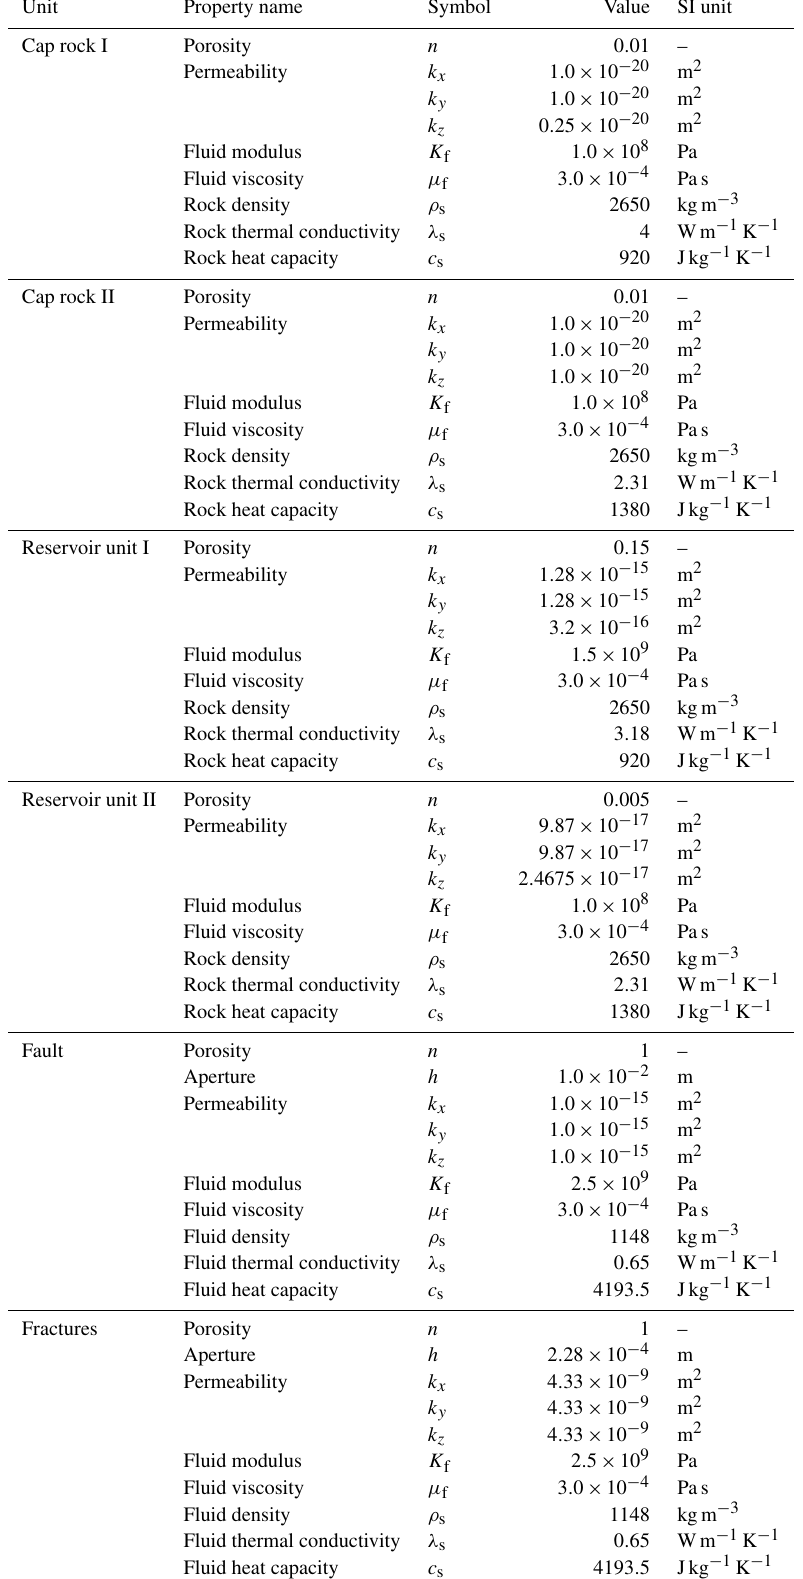
Table 4. Material properties for the multifrac reservoir